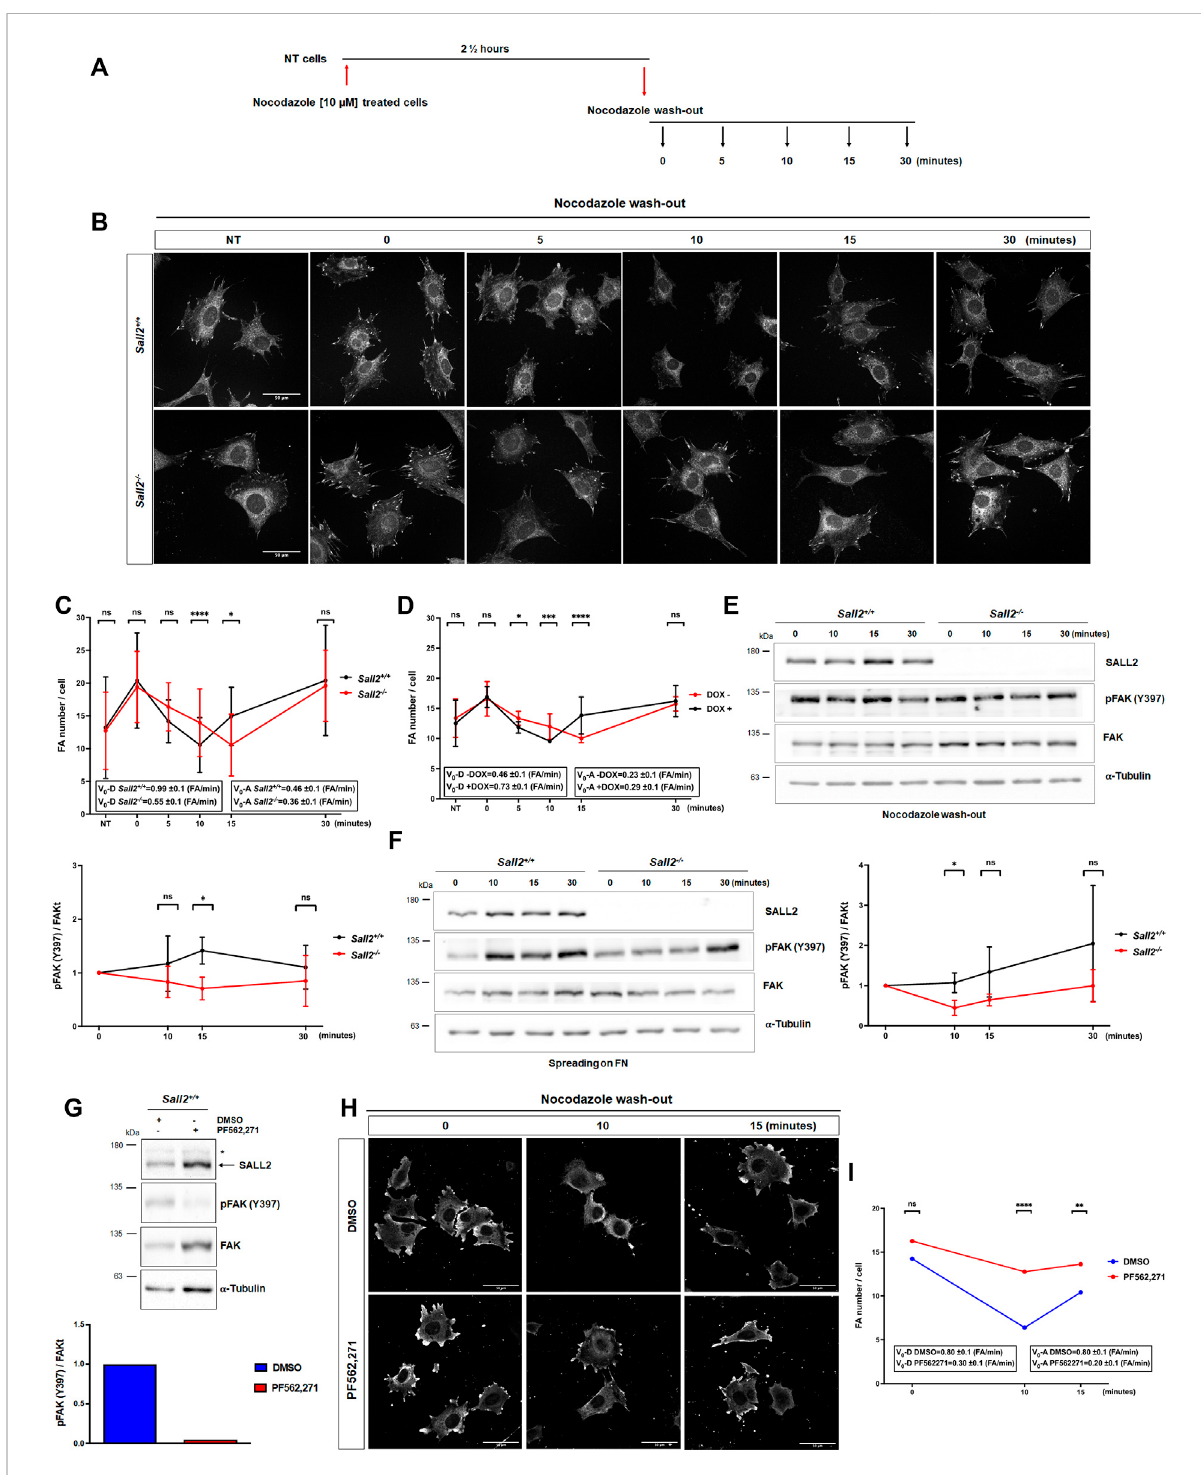
FIGURE 4 Sall2 promotes focal adhesion dynamics. (A) Schematic representation of nocodazole treatment and wash-out. (B) Representative confocal images (63x) from Sall2 +/+ and Sall2 − / − iMEFs incubated with 10 μ M of nocodazole in serum-free medium. Nocodazole was washed-out at different times. Cells were fi xed, and FAs were stained with anti-vinculin antibody (white). (C,D) Quanti fi cation of FA number per cell from Sall2 +/+ and Sall2 − / − iMEFs (C) and the Tet-On Sall2 iMEFs inducible model (D) . Graphs included initial velocity (Vo-D) of FA disassembly and initial velocity (Vo-A) of FA assembly. For each experiment, at least 60 cells were analyzed per condition. (E) Left, FAK autophosphorylation (Y397) was evaluated by western